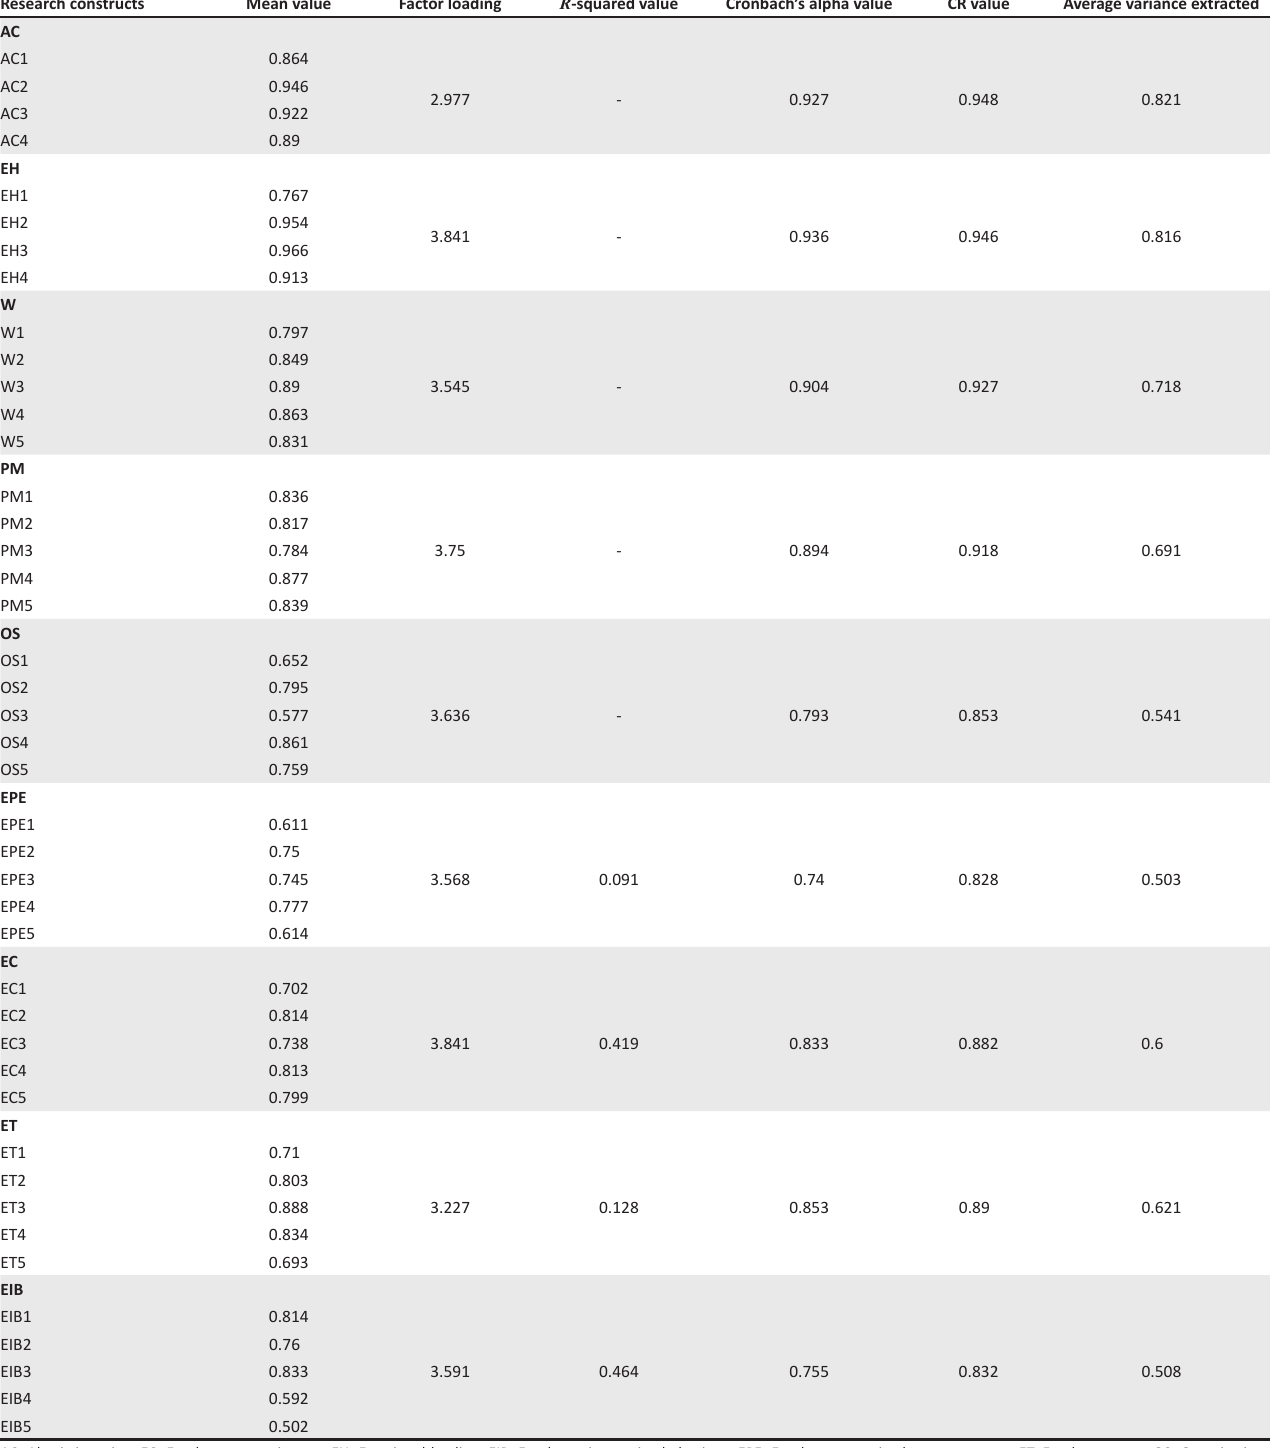
TABLE 1: Accuracy analysis statistics. Research